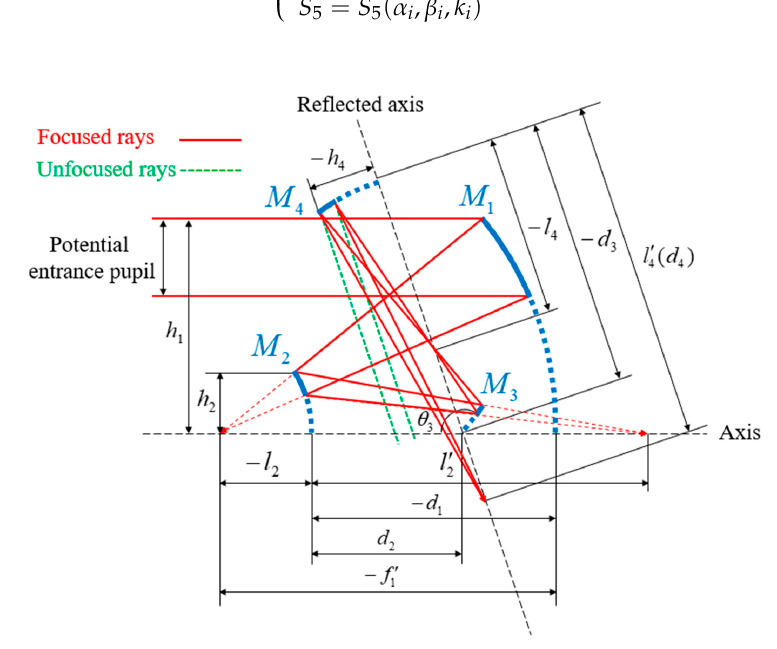
Figure 5. The layout of the four-mirror system.